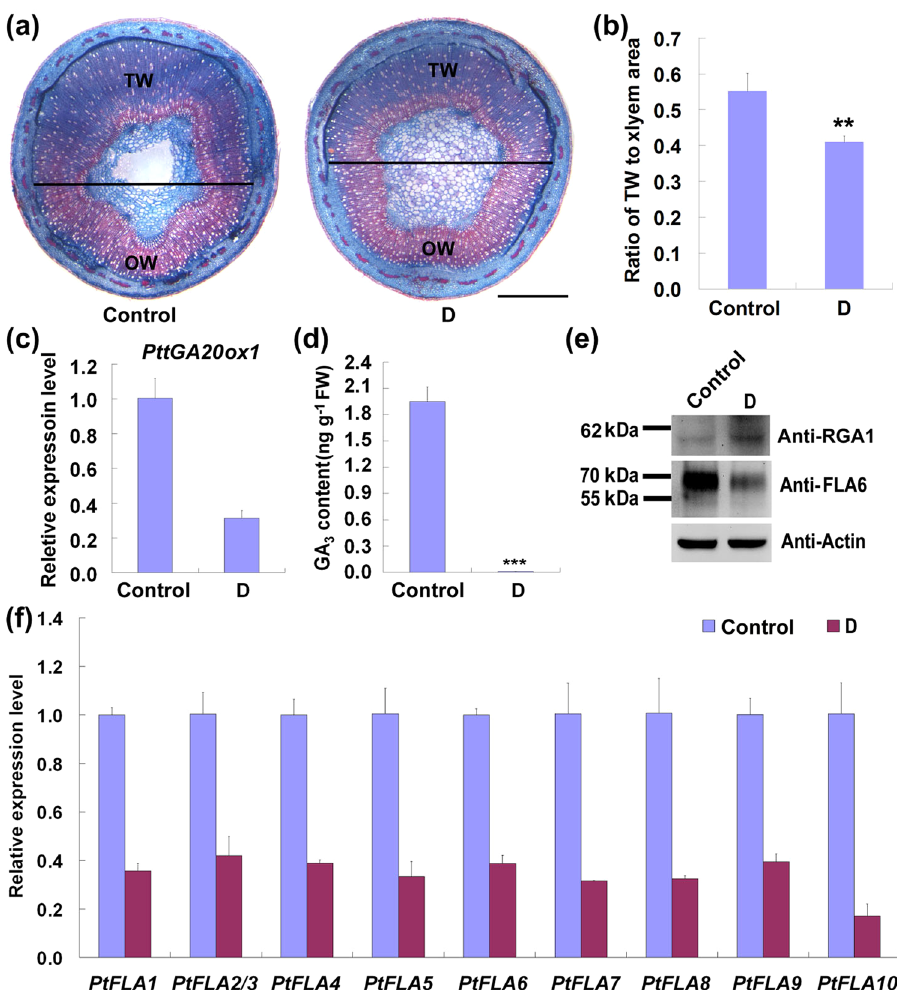
Figure 6. TW formation was inhibited by daminozide treatment. ( a ) Cross-sections of bended stems treated with daminozide or lanolin alone. The horizontal line indicates the division between TW side and OW side. TW, tension wood; OW, opposite wood. Scale bars = 1 mm. ( b ) Radio of TW area in the xylem of bended stems treated with daminozide. Error bars represent the SDs from five plants. ( c ) Expression analysis of PttGA20ox1 in the TW side of bended stems treated with daminozide. ( d ) GA 3 content in the TW side of daminozide treated stems. ( e ) Western blotting analysis of the poplar DELLA protein and PtFLA6 protein in the xylem of the TW side. An amount of 30 μ g plant proteins extracted from the TW xylem tissues of bended stems treated with daminozide or lanolin were separated by 10% SDS-PAGE and hybridized with AtRGA1 antibodies (Anti- RGA1), PtFLA6 antibodies (Anti-FLA6) or plant actin antibodies (Anti-Actin). ( f ) qRT-PCR analysis of PtFLA s in the TW xylem tissues of bended stems treated with daminozide. Gene expression level in control was set to 1. Error bars represent the SDs from three biological replicates. Control, bended stems painted with lanolin alone; D, bended stems painted with daminozide. ** Indicates a significant difference in comparison to control at P < 0.01 (Student’s